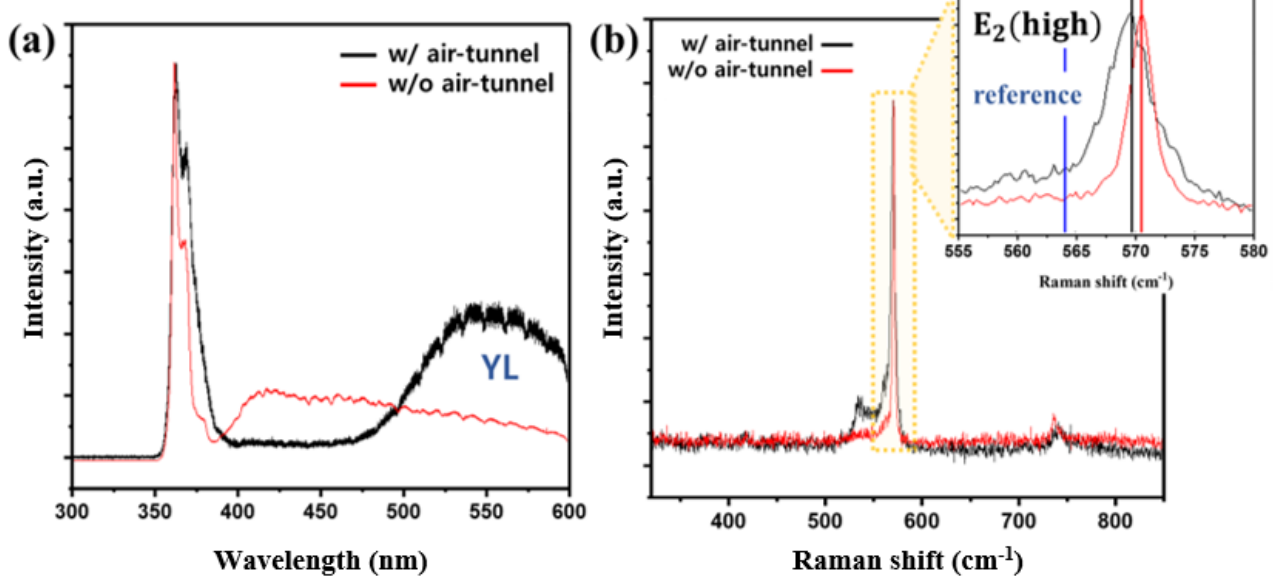
Figure 4. ( a ) PL spectra of GaN films with/without an air tunnel at 300 K. ( b ) Raman spectroscopy of GaN films with/without an air tunnel.